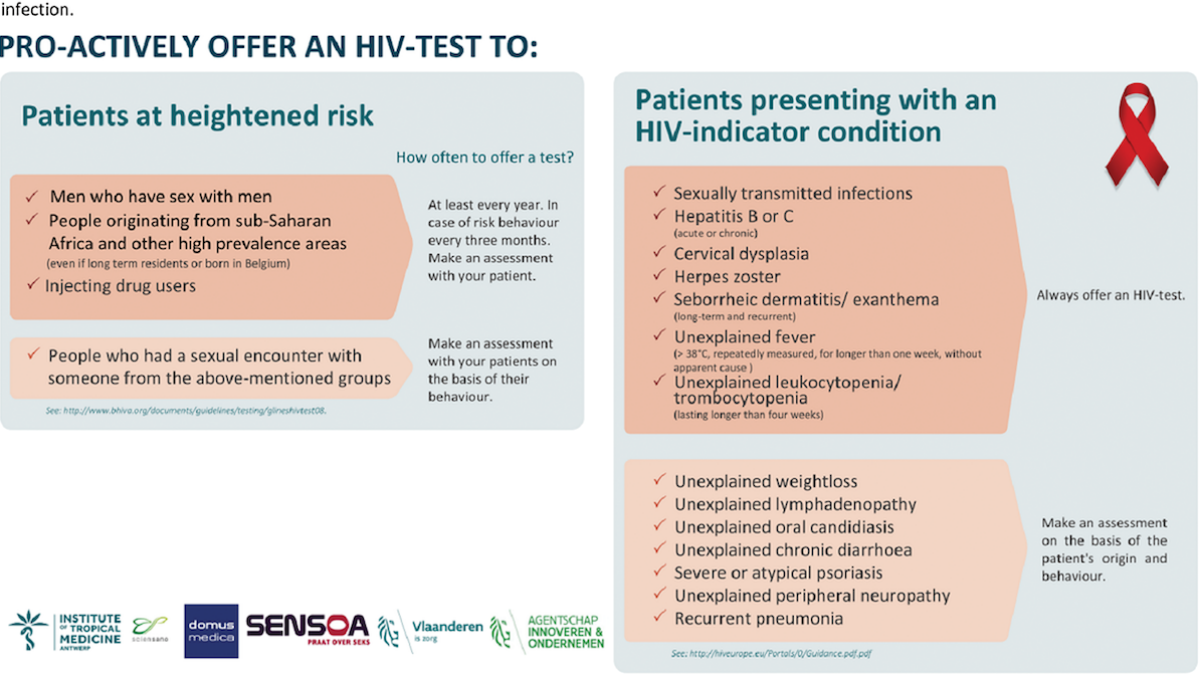
Figure 3. Advice HIV-testing by GPs (front